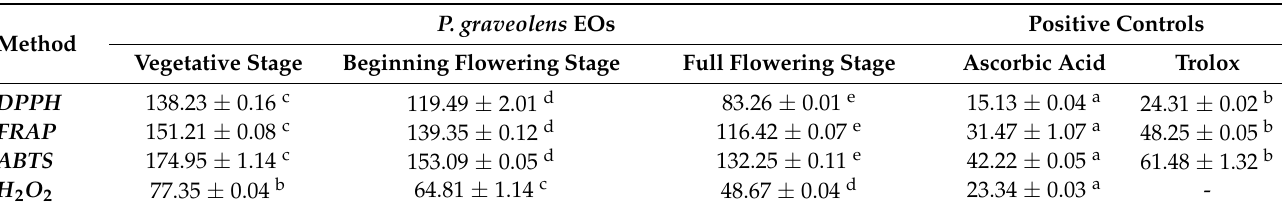
Table 4. The antioxidant activity of P. graveolens EOs expressed as IC 50